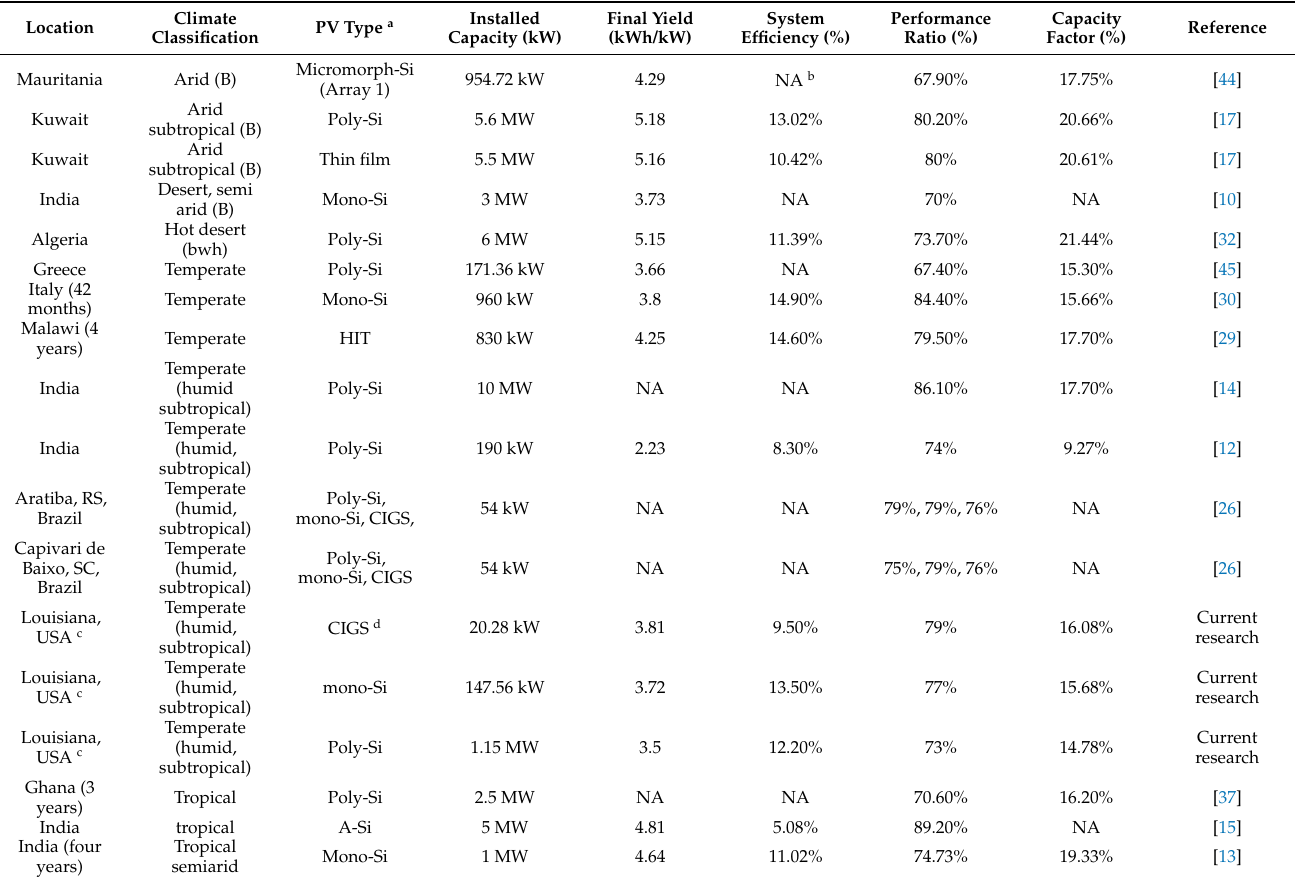
Table 6. Comparison of performance of different PV